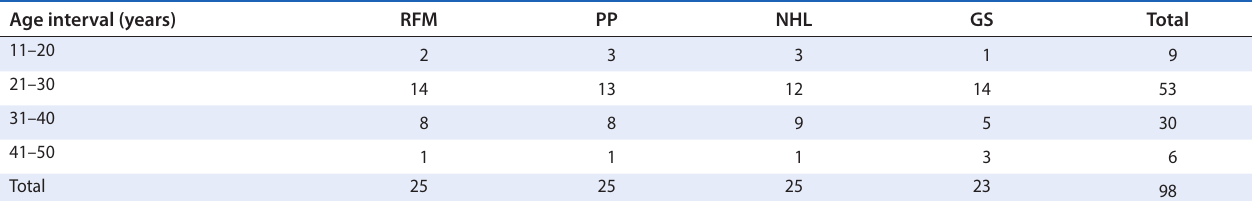
Table 1: Age distribution of respondents per hospital Age interval